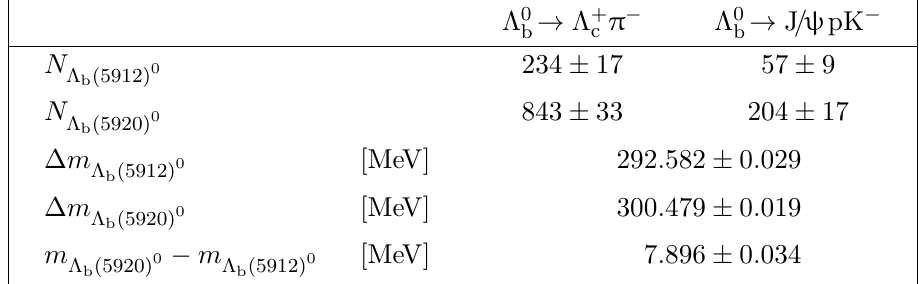
(cid:25)(cid:25) spectra. b